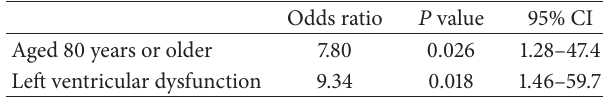
Table 4: Factors associated with the development of